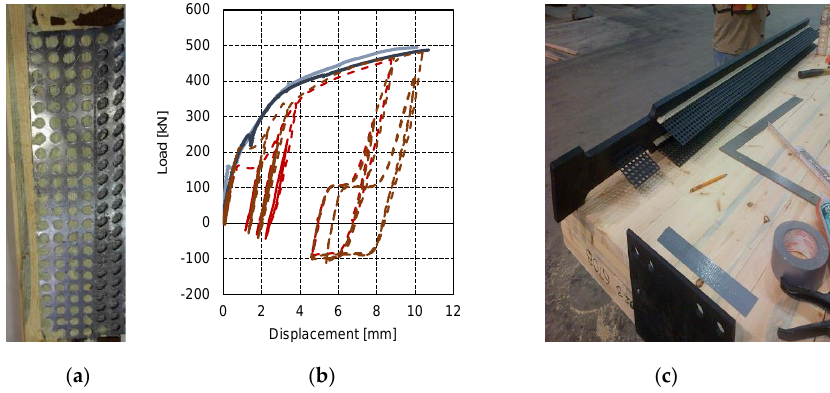
Figure 7. HSK-based HD: ( a ) steel plate after testing; ( b ) uplift force – displacement curve; ( c ) installed HD (photo credit: ( a ), Xiaoyue Zhang; ( c ), Robert Malczyk, reprinted with permission).